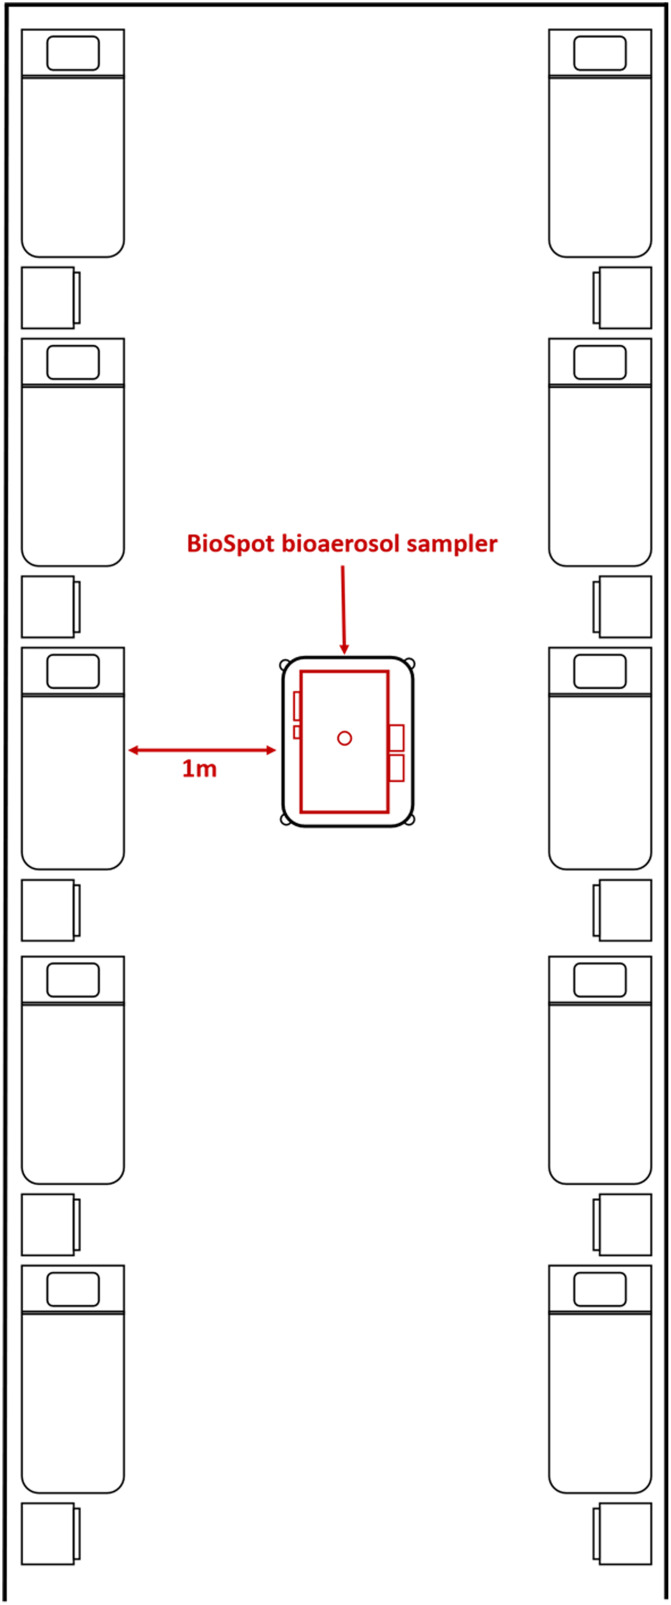
Air sampling set-up in community isolation facility cubicle.